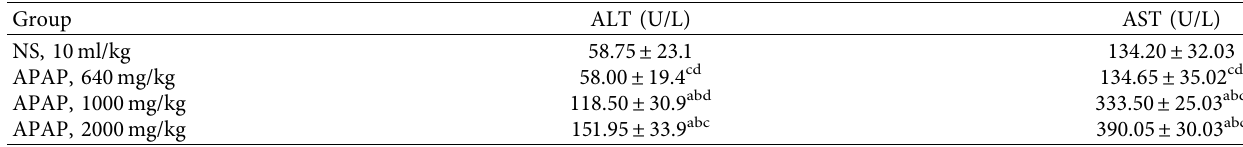
Table 1: Effects of different doses of APAP on serum levels of the liver enzymes (ALT and AST). Group